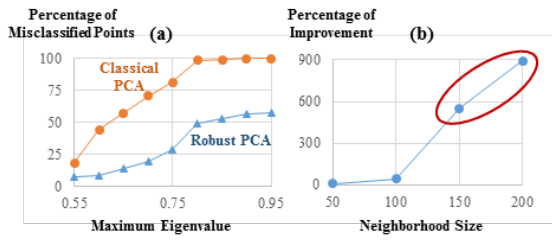
Figure 3. a) Percentage of misclassified points with respect to the threshold; b) percentage of improvement of the misclassification with respect to the neighbourhood size